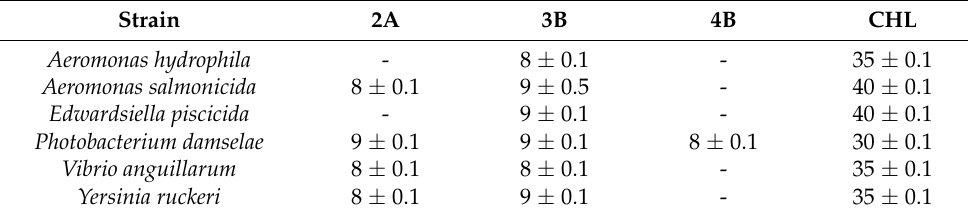
Table 2. Antimicrobial activity of G. gracilis ethanolic fractions obtained after 30 min extraction at room temperature and chloramphenicol (CHL) against several fish pathogenic bacteria strains. The results are expressed as mean diameter of inhibition halos (mm) ± standard deviation ( n = 4).